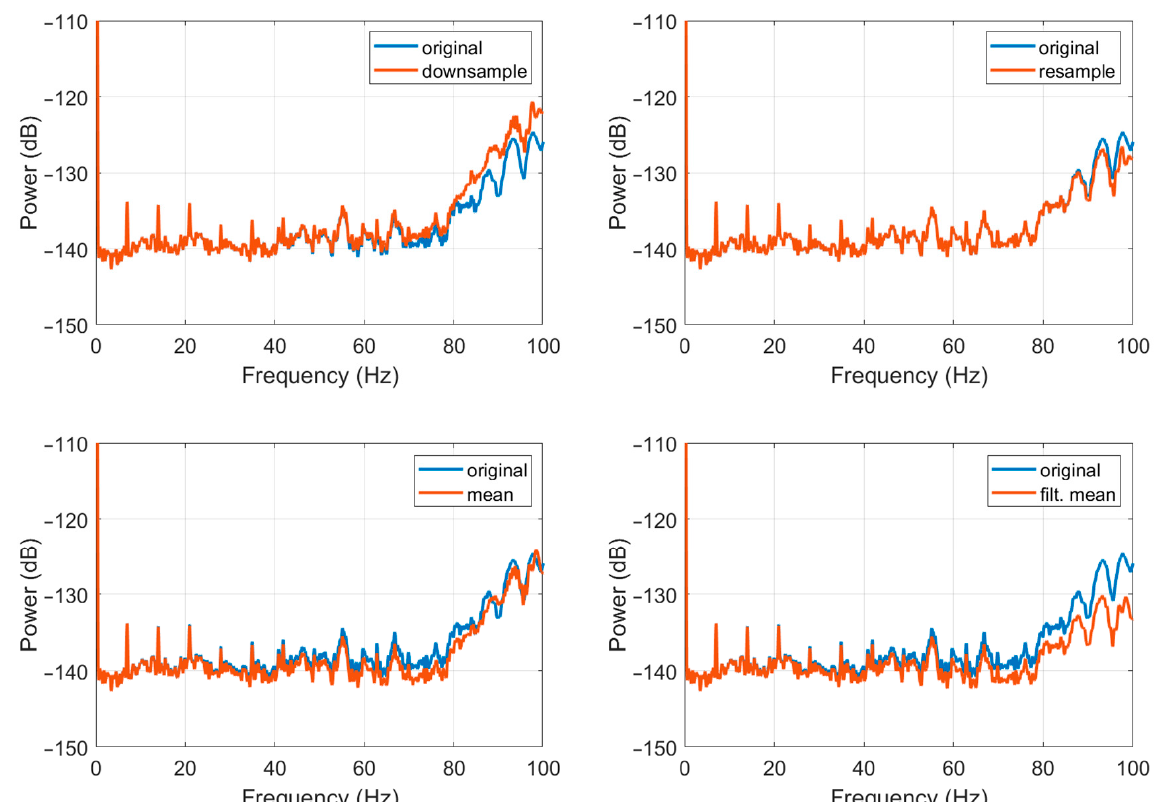
Figure 6. Comparison of the spectral accuracy of the different investigated resampling methods applied to a signal from Figure 5b.